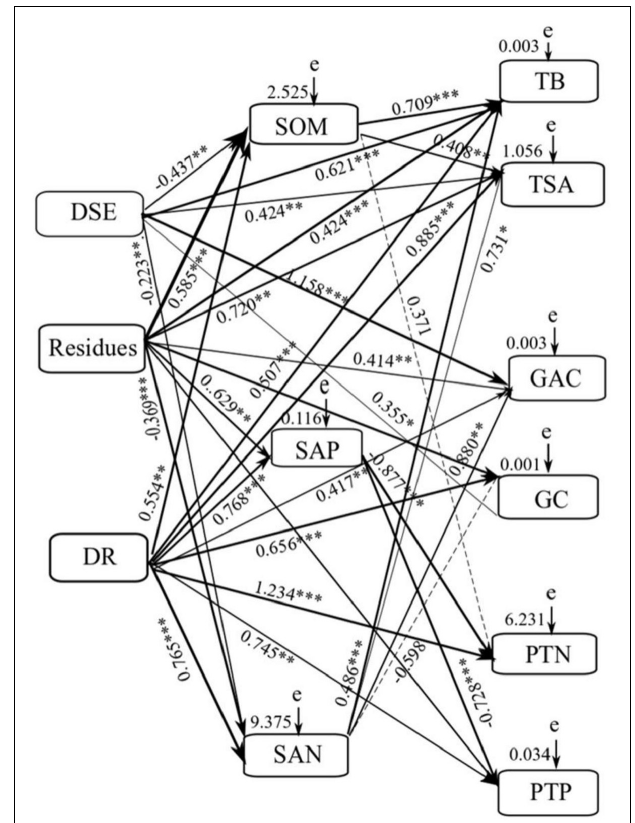
FIGURE 6 | Structural equation model (SEM) showing the causal relationships among soil factors, DSE species, residues and growth indicators, active ingredient and nutrients content. The final model fitted the data well: maximum likelihood, X 2 = 130.161, df = 21, P = 0.007, goodness-of-fit index = 0.741, Akaike information criteria = 156.672, and root mean square error of approximation = 0.344. Solid lines and dashed lines indicate significant and non-significant pathways, respectively. The width of the solid lines indicates the strength of the causal effect, and the numbers near the arrows indicate the standardized path coefficients ( ∗ P < 0.05, ∗∗ P < 0.01, ∗∗∗ P < 0.001). DR = combination of DSE and residues. SOM = soil organic matter. SAP = soil available P. SAN = soil available N. e = the values of residuals. TB = total biomass. TSA = root surface area. GAC = glycyrrhizinic acid content. GC = glycyrrizin content. PTN = plant total nitrogen. PTP = plant total